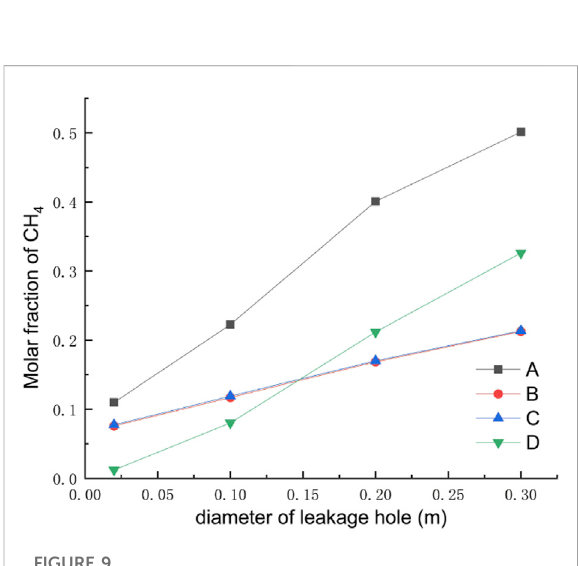
FIGURE 10 Diffusionheightdiagramofeachleakageapertureatdifferent